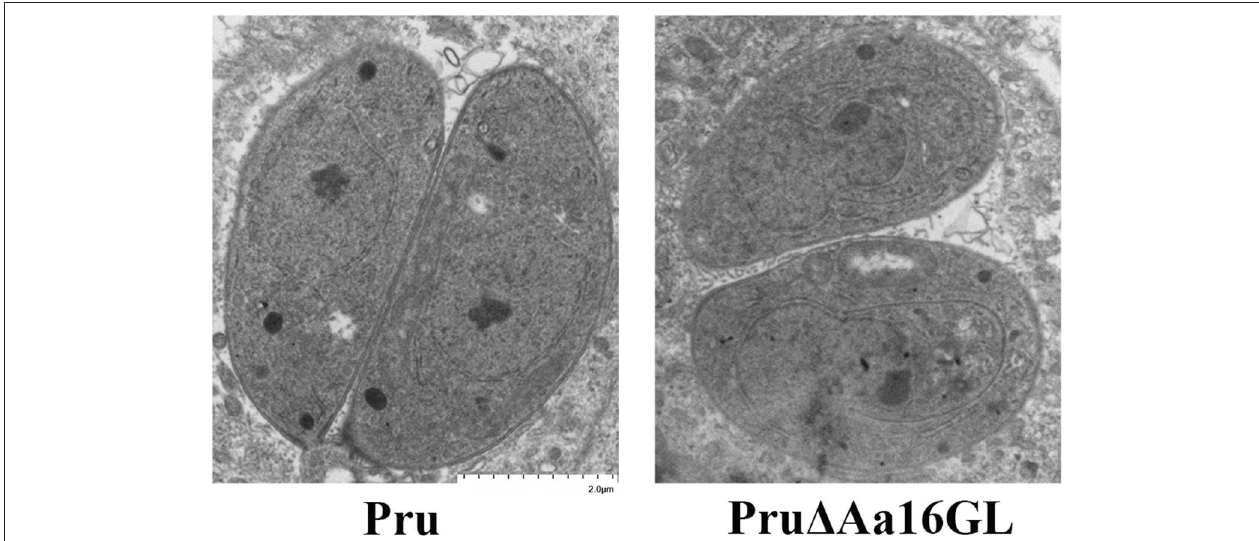
FIGURE 6 | Evaluation of amylopectin accumulation in the Aa16GL mutant tachyzoites by transmission electron microscope. Parental Pru strain or Pru 1 Aa16GL mutant strain was allowed to infect HFF monolayers under normal conditions for 20h. Samples were fixed and prepared for transmission electron microscope. No amylopectin granules or accumulation of lipid was observed in the Pru 1 Aa16GL mutant or the parental Pru strain.